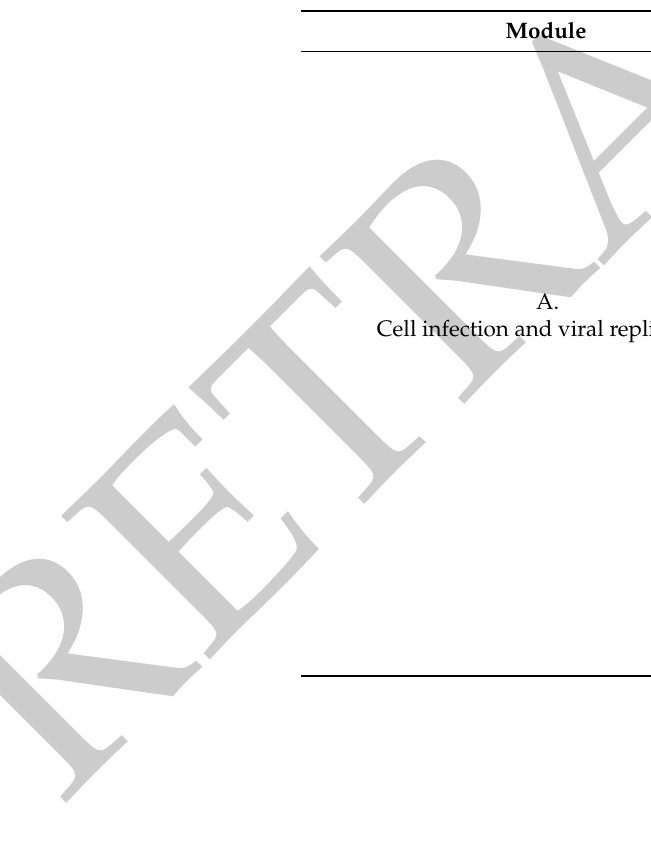
Table 2. COVID-19 model biological keys based framework and modular logic. * Submodels and Figure S1. and garnered by scoping review of Montando and